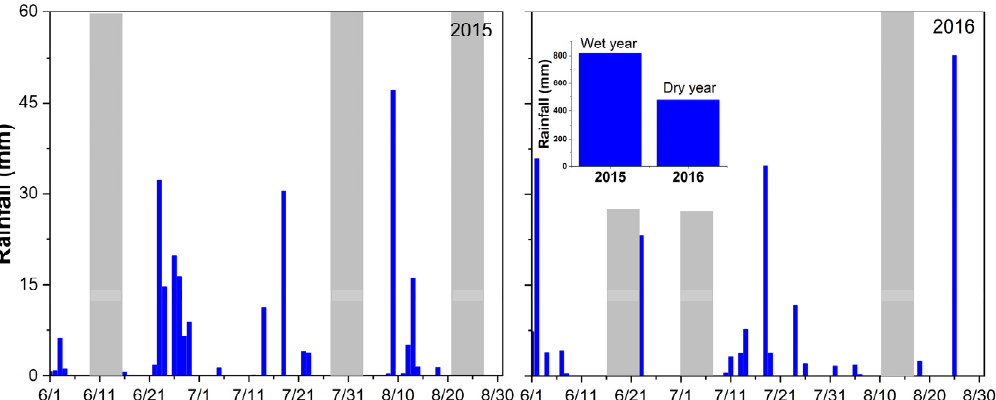
Figure 1. Gross rainfall distribution and the six selected investigation times during the experimental periods in 2015 and 2016. Gray rectangles indicate the periods during which the study was carried out.